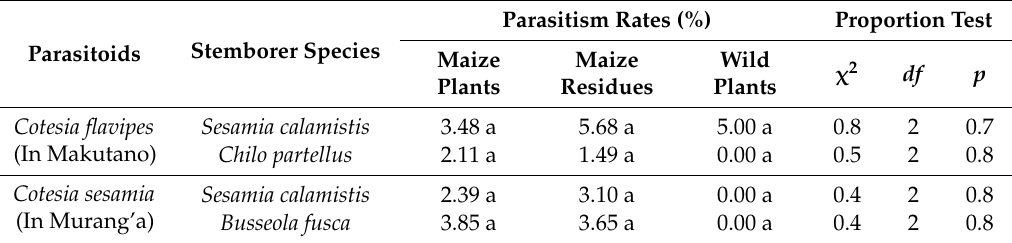
Table 8. The parasitism rate of Cotesia flavipes and Cotesia sesamia after and during the release according to the stemborer species and refugia habitat. Parasitism Rates (%) Proportion Parasitoids Stemborer Species